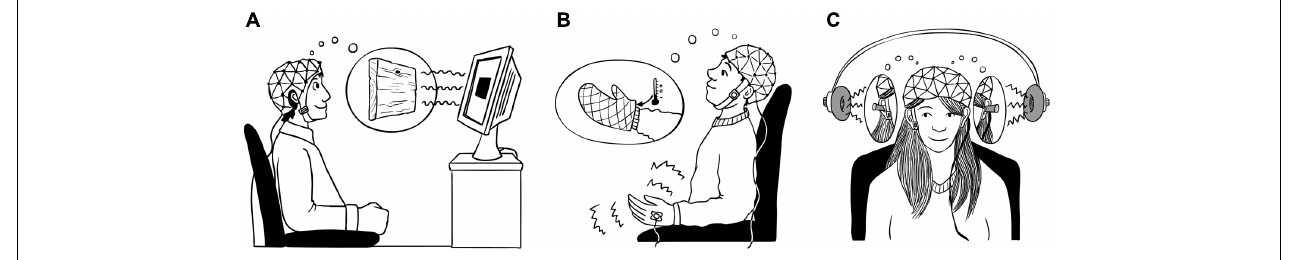
FIGURE 1 | Illustration of the three EEG studies using hypnotic suggestions to block sensory processing. (A) Participants had to count rare visual stimuli on the screen. In the hypnosis condition, they were suggested that a wooden board is blocking their vision on the screen, so they cannot see the visual stimuli. (B) Participants received electrical pain stimuli on their hand. In the hypnosis condition, they were suggested that a cooling and numbing glove is covering their hand, so they cannot feel the stimuli. (C) Participants had to press a button when they heard a rare sound. In the hypnosis condition, they were suggested that earplugs keep them from hearing the